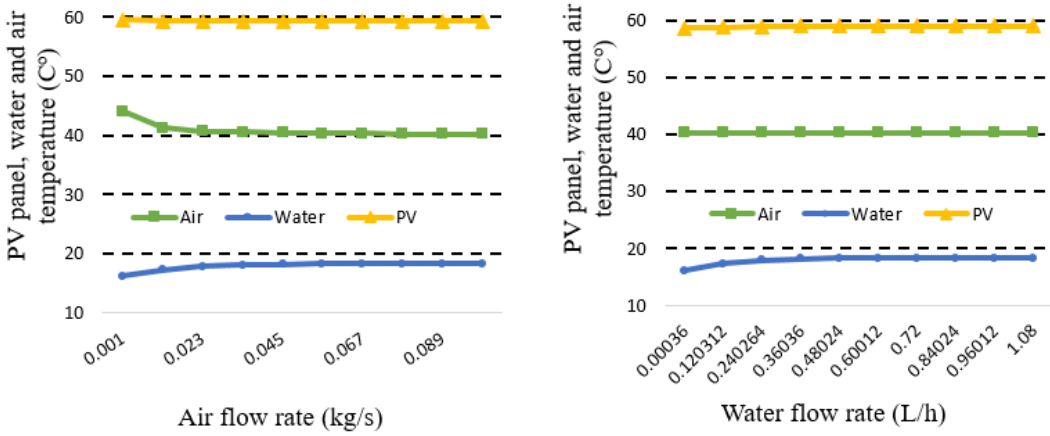
Figure 17. Effect of water and air flow rates on panel’s temperature.